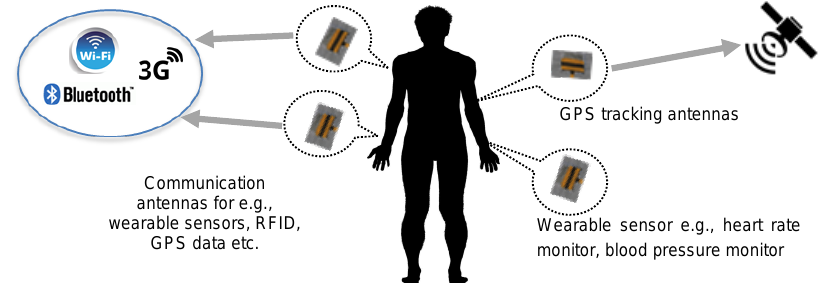
Figure 1. Examples of wearable antennas integrated with wearable electronic devices for many applications. Through wearable technology, various Internet of Things (IoT) applications can be supported such as healthcare monitoring via wearable sensors, human tracking through body-centric radio-frequency identification (RFID), sportsmen or patient tracking via a wearable global positioning system (GPS) receiver and many more.